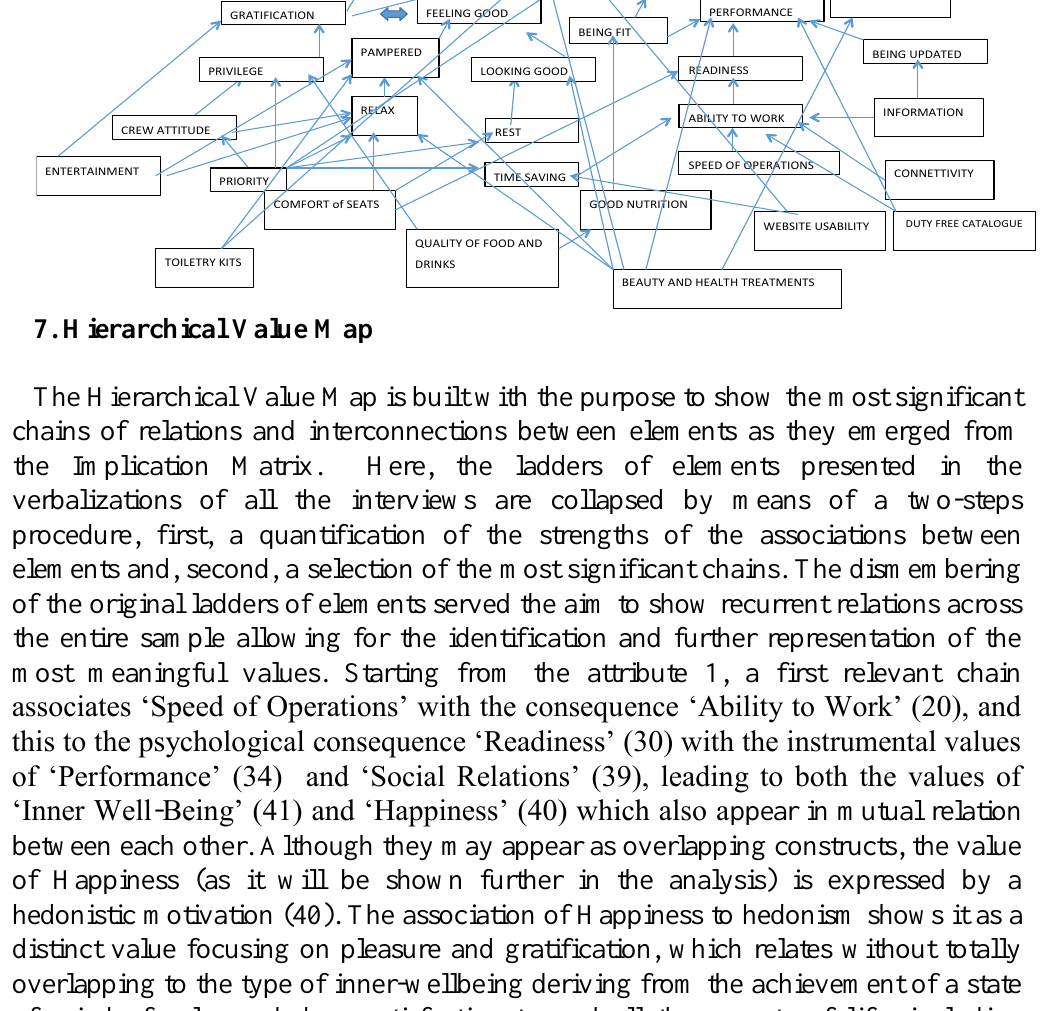
Table 2: Second Wave Analysis: Attributes – Consequences - Values